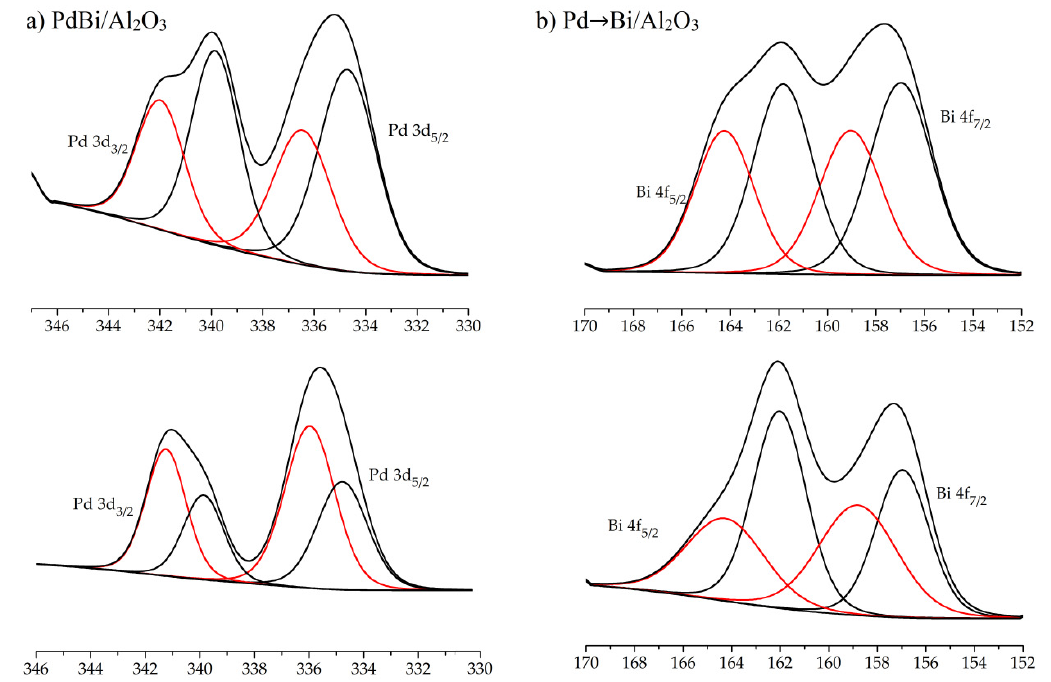
Figure 13. X-rayphotoelectronspectraofthesurfacesofcatalystsamplesaftercatalytictests( a )PdBi / Al 2 O 3 , Figure 13. X-ray photoelectron spectra of the surfaces of catalyst samples after catalytic tests ( a ) ( b ) PdBi / Al 2 O 3 PdBi/Al 2 O 3 , ( b ) PdBi/Al 2 O 3 .